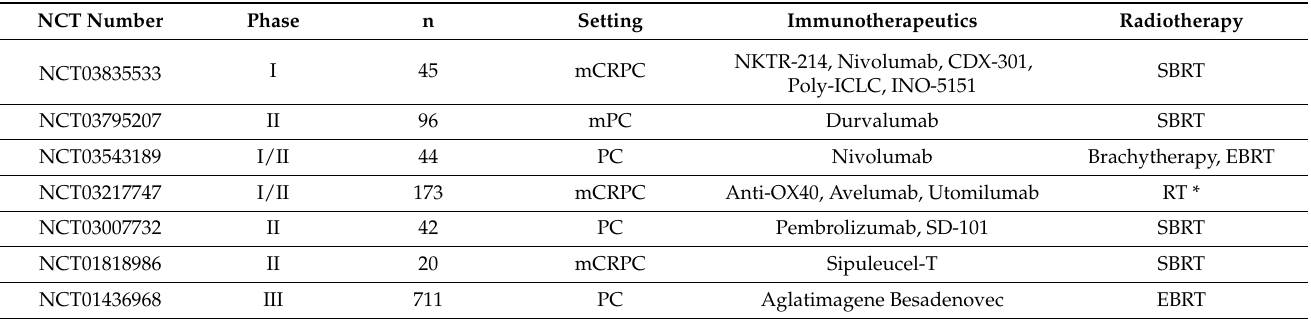
Table 1. Ongoing trials assessing combinations of radiotherapy and